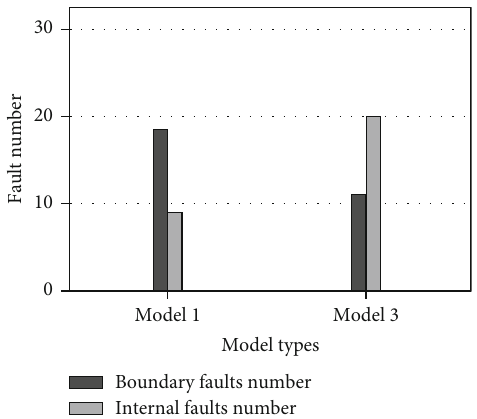
Figure 9: Number of faults in the reference model and model 3, where the number of faults is the sum of sections 1 – 4.